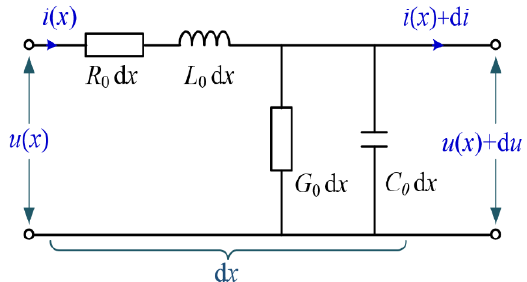
Figure 10. Distributed parameter model of the power